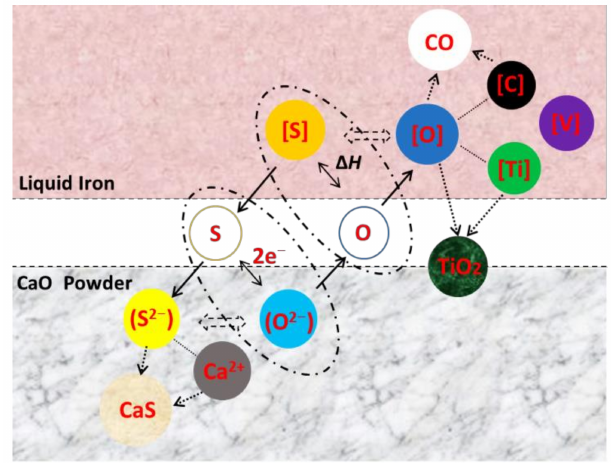
Figure 10. Schematic diagram of CaO desulfurization